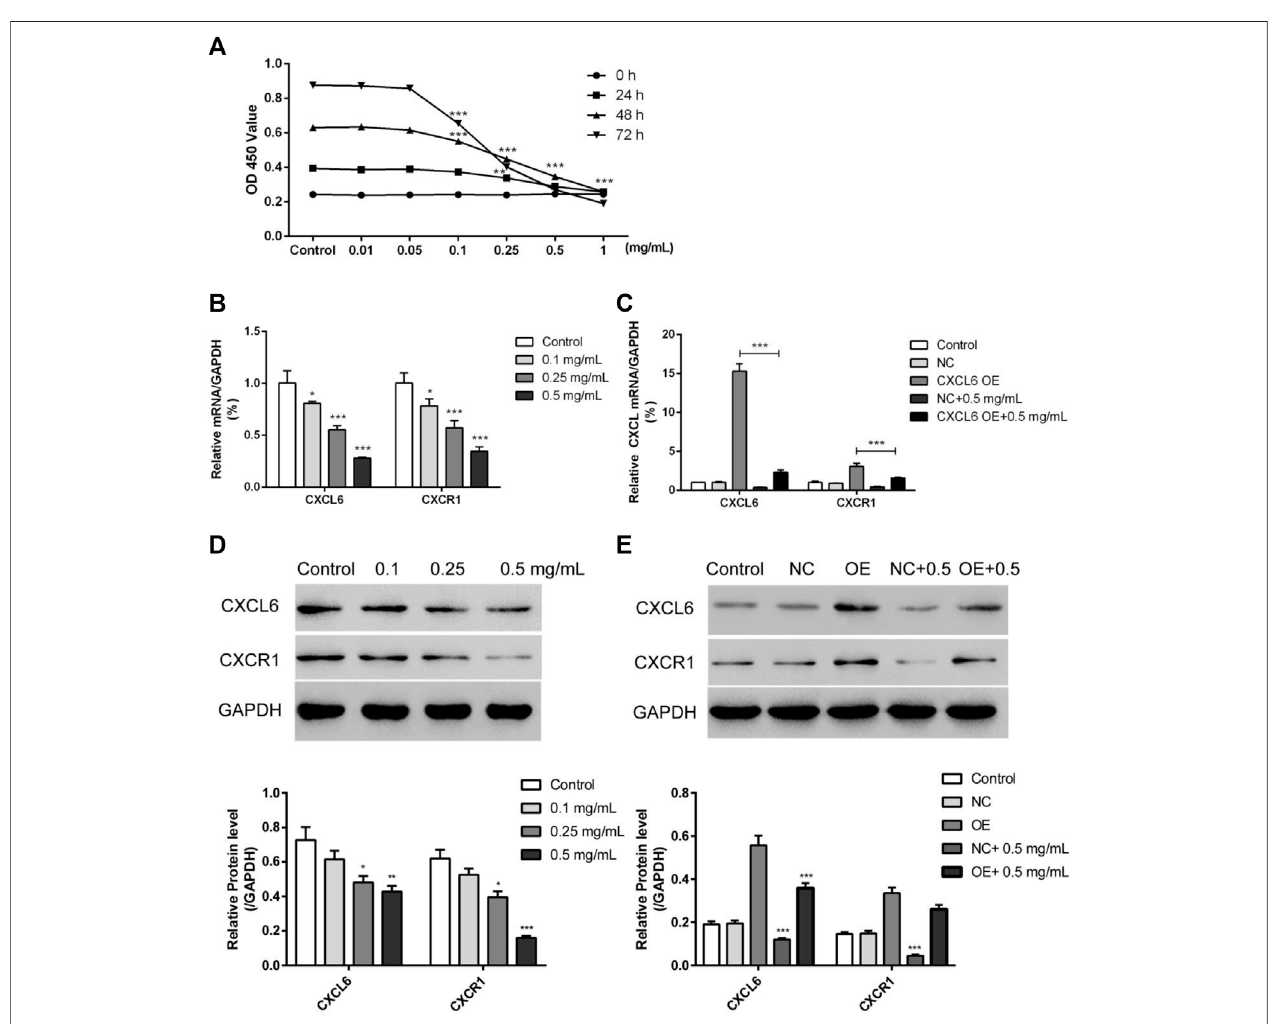
FIGURE4| EHFinhibitedtheproliferationofNRK-49FcellsanddecreasedtheexpressionofCXCL6andCXCR1. (A) CCK8analysisofNRK-49Fcellproliferation. (B) , (D) ThemRNAandproteinexpressionsofCXCL6andCXCR1indifferentEHFdosegroupswereexaminedbyqRT-PCRandWesternblotting.GAPDHwasserved asaloadingcontrol. (C) , (E) Theeffectof0.5mg/mlEHFontheexpressionofCXCL6and CXCR1inCXCL6overexpressionNRK-49FcellswasevaluatedbyqRT-PCR and Western blotting. *p < 0.05, **p < 0.01, ***p < 0.001 versus control group.